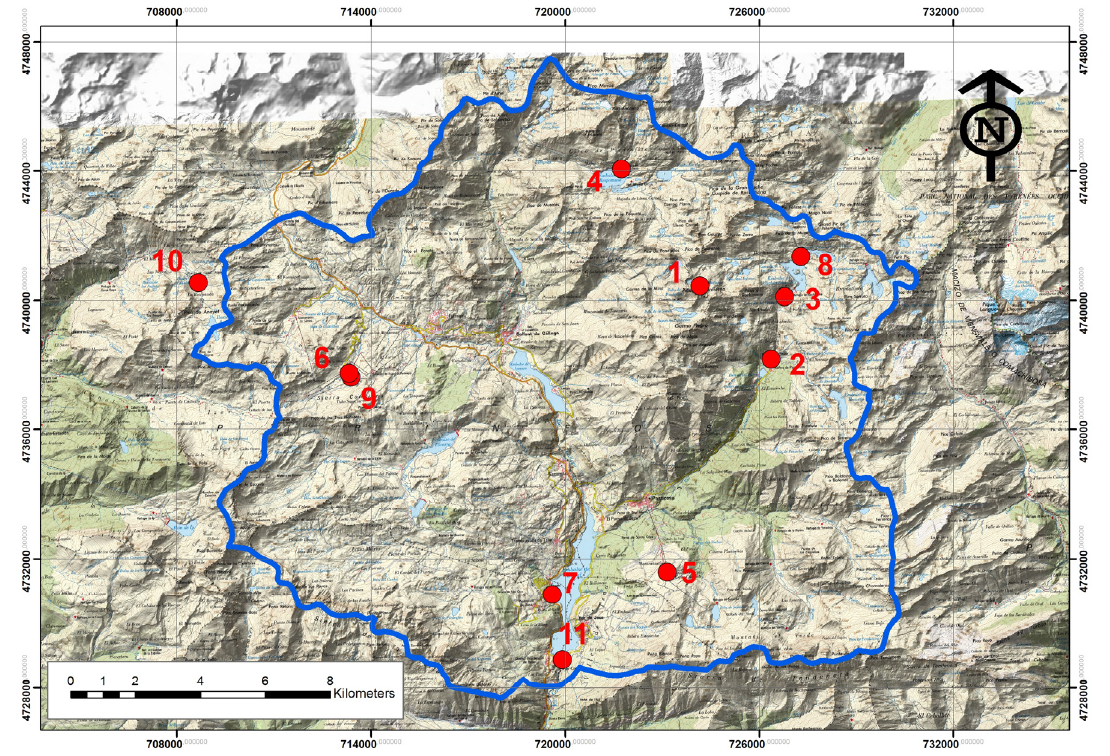
Figure 6. Upper basin of the G á llego River, up to the B ú bal Reservoir (blue line). 1: Infierno Glacier; 2: Casa de Piedra weather station; 3: Bachimaña weather station; 4: Respomuso weather station; 5: Panticosa-Petrosos weather station; 6: Sarrios-Formigal weather station; 7: Biescas-B ú bal Reservoir